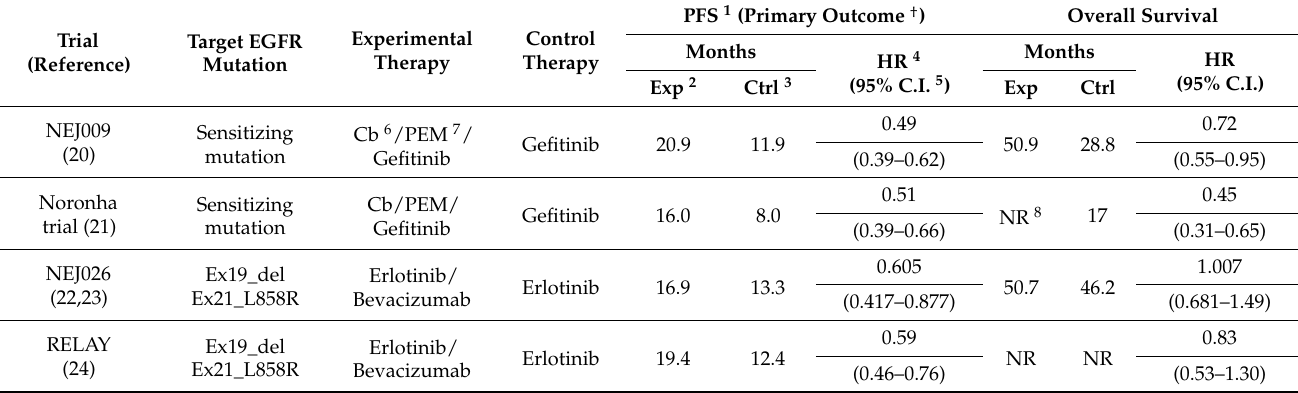
Table 2. List of clinical trials evaluating EGFR-TKI combination therapy in EGFR-mutated lung cancer. Trial Target EGFR (Reference)